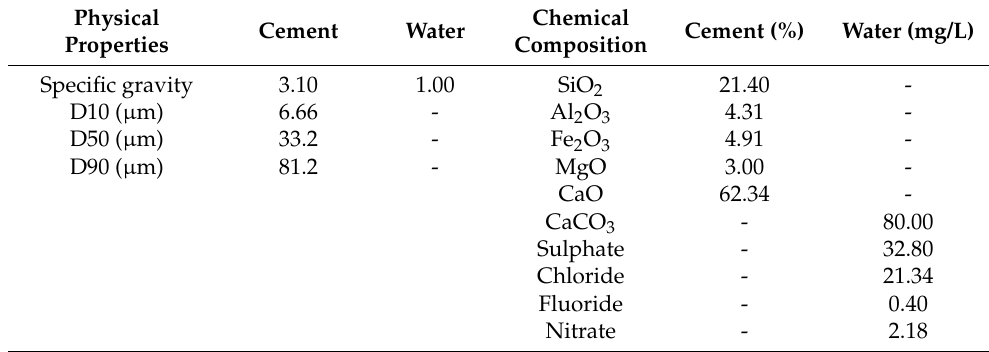
Table 2. Main physical and chemical properties of the cement and water.